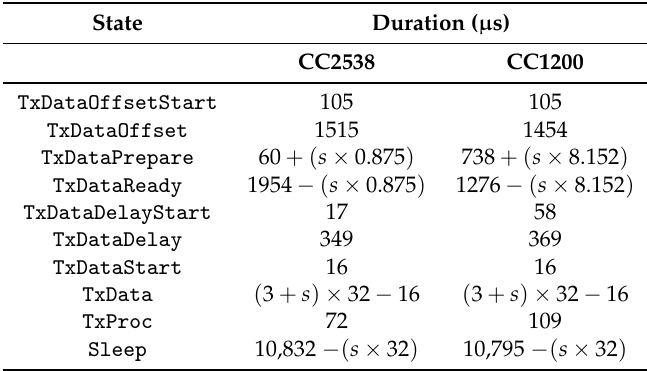
Table 12. State durations in the TxData time slot with a total length of 15ms and s being the packet size in